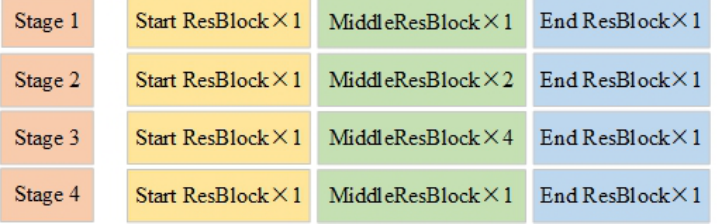
Figure 3. The composition of ResBlock in each